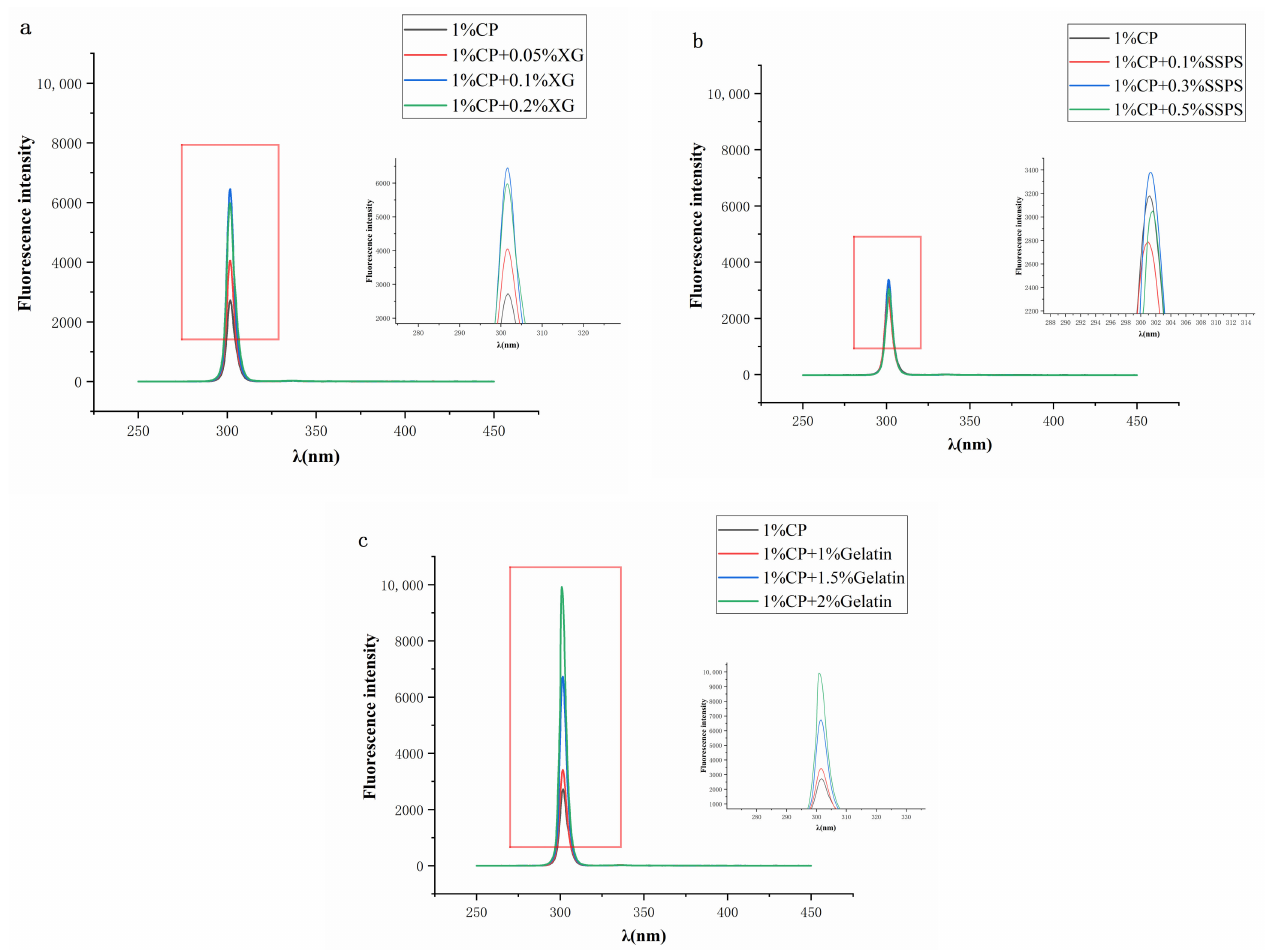
Figure 4. Intrinsic fluorescence intensity of CP-Hydrocolloid systems. ( a ) CP-XG; ( b ) CP-SPSS; ( c ) CP-Gelatin. (CP-Coconut protein, XG-Xanthan gum, SSPS-Soluble soybean polysaccharide).